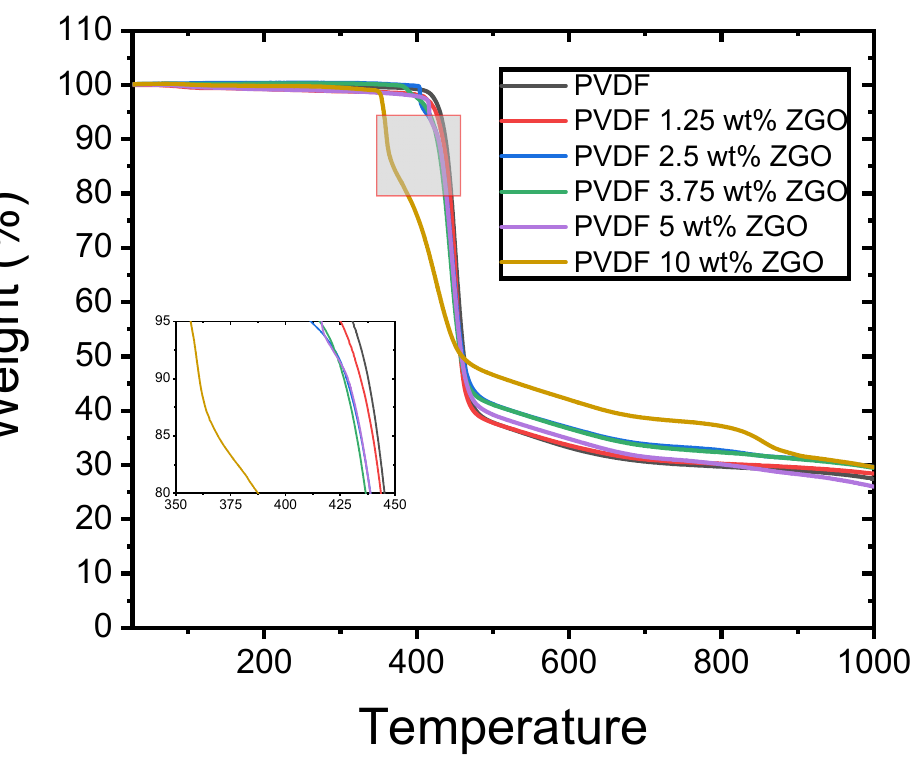
Figure 5. TGA curve for PVDF and PVDF-ZGO composite fibers.